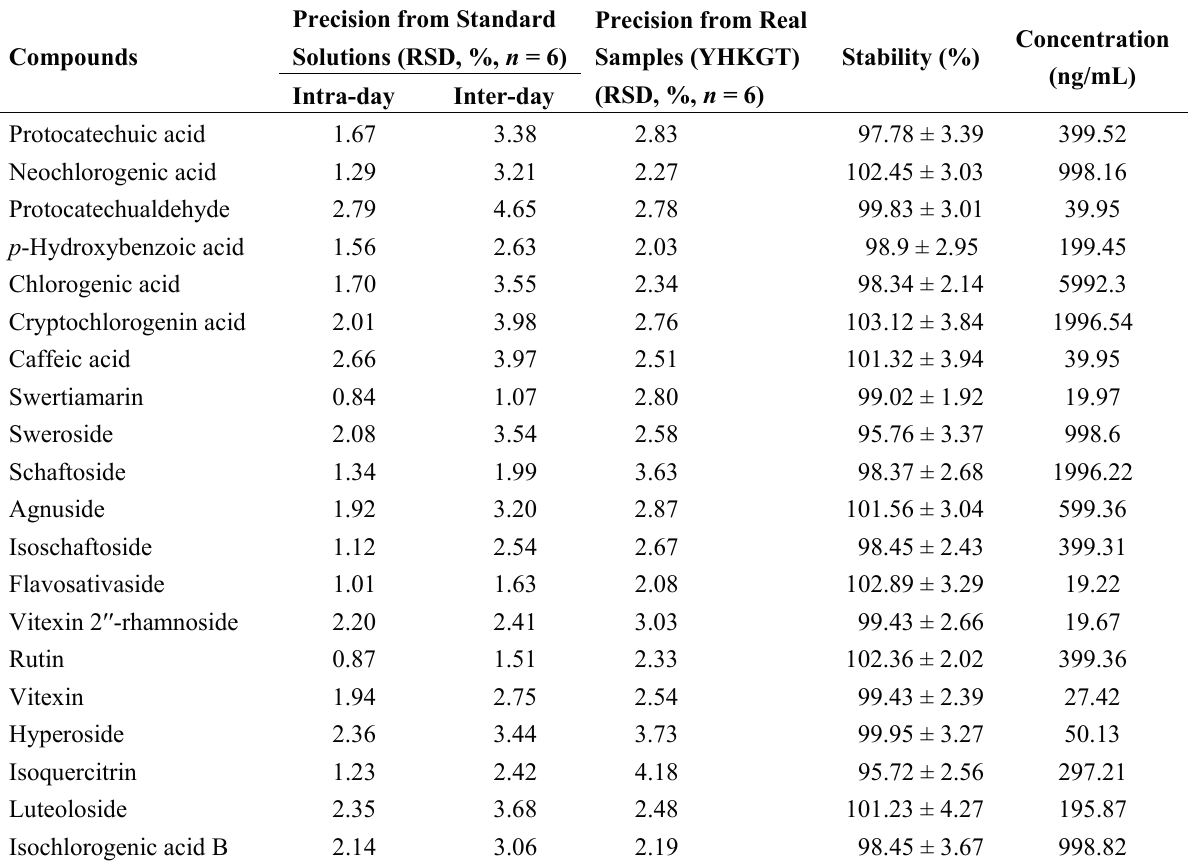
Table 2. Precision, repeatability and stability of the 29 investigated compounds.